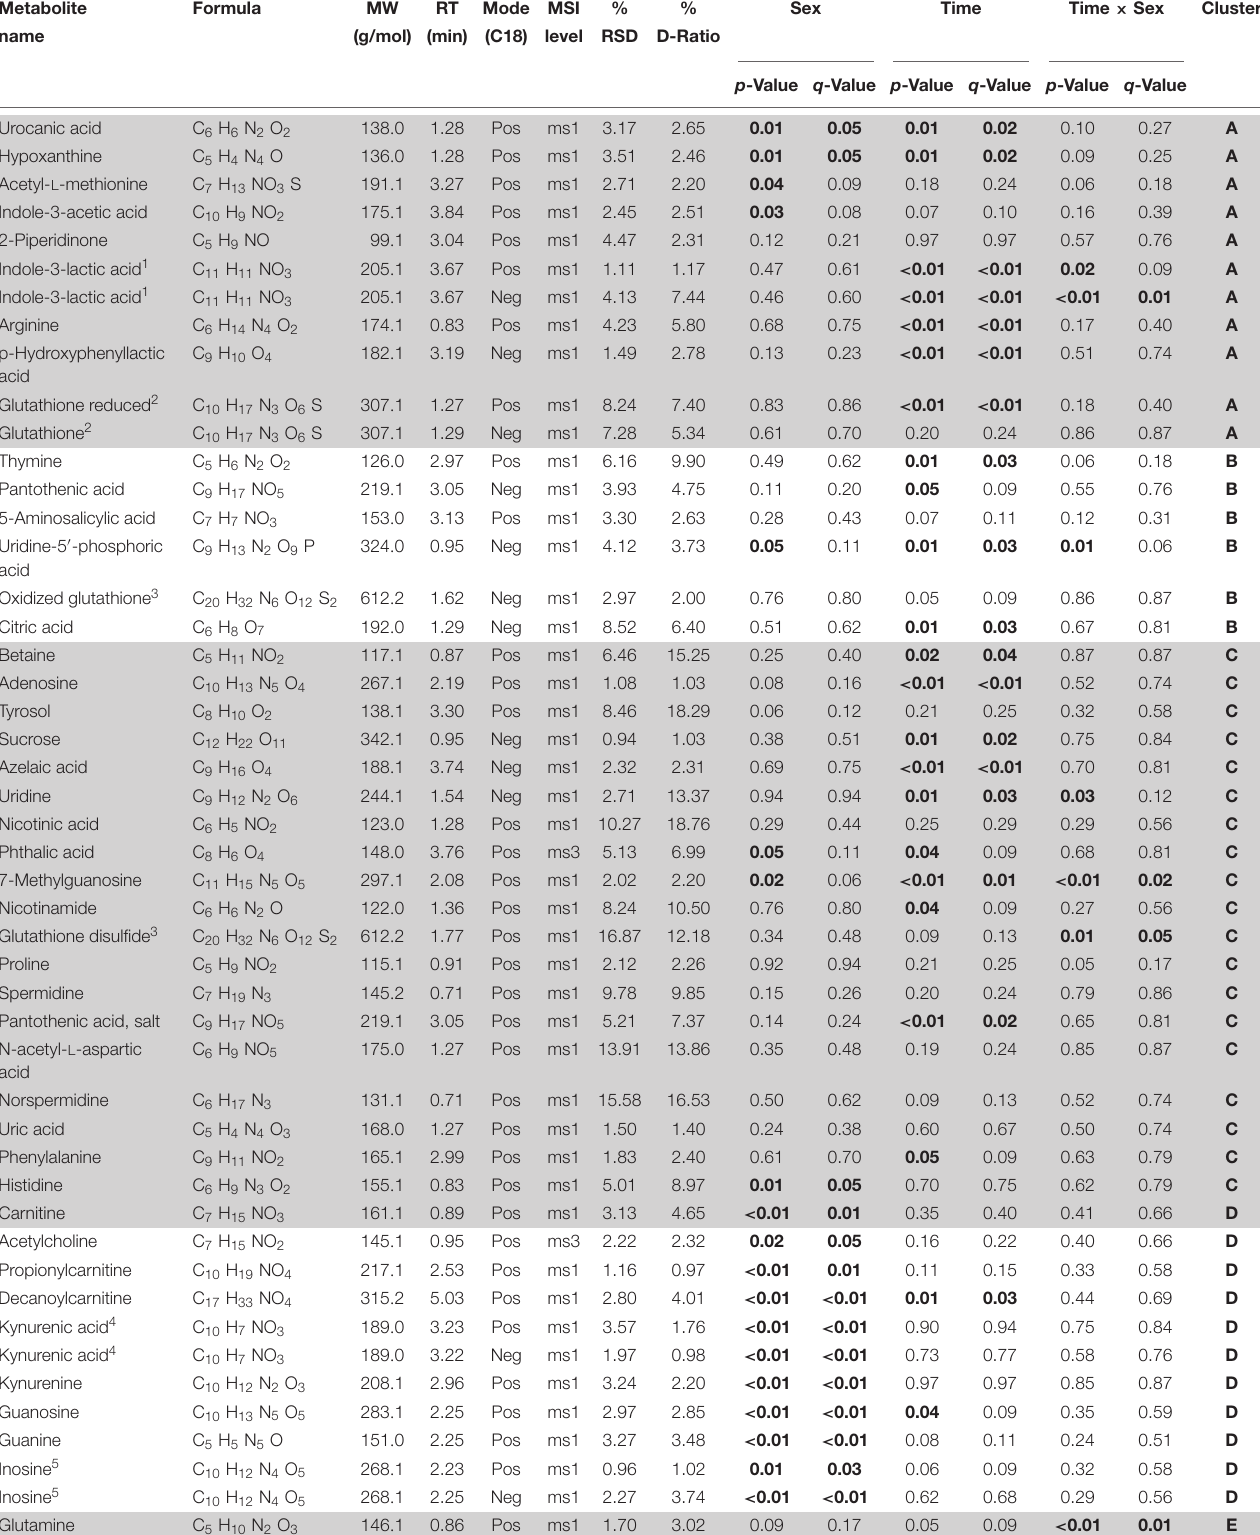
TABLE 1 | Metabolites identified in Cherax tenuimanus haemolymph